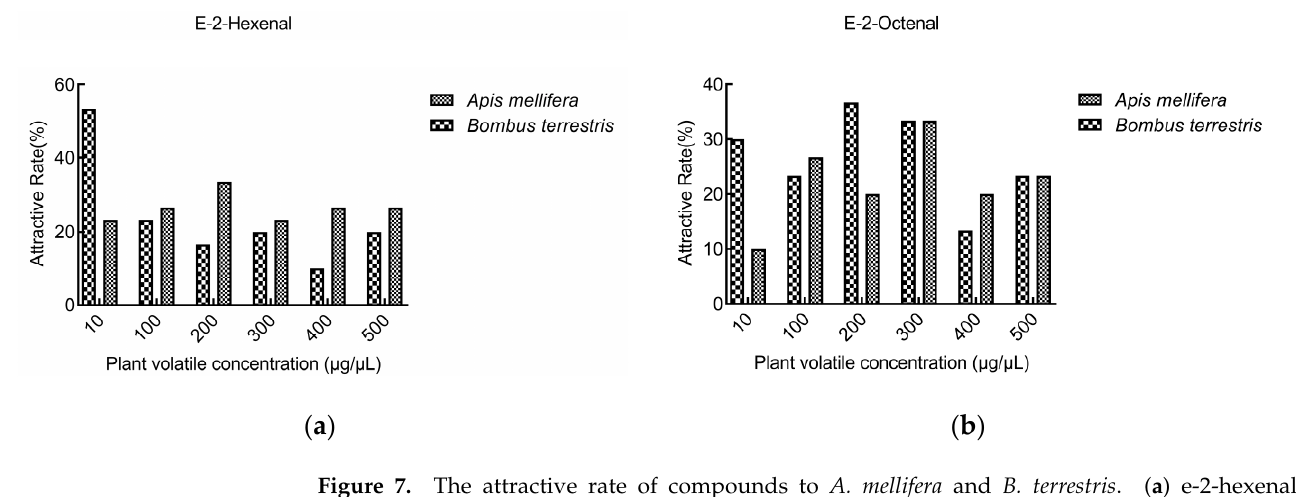
Figure 7. The attractive rate of compounds to A. mellifera and B. terrestris . ( a ) e-2-hexenal; ( b ) e-2-octenal.